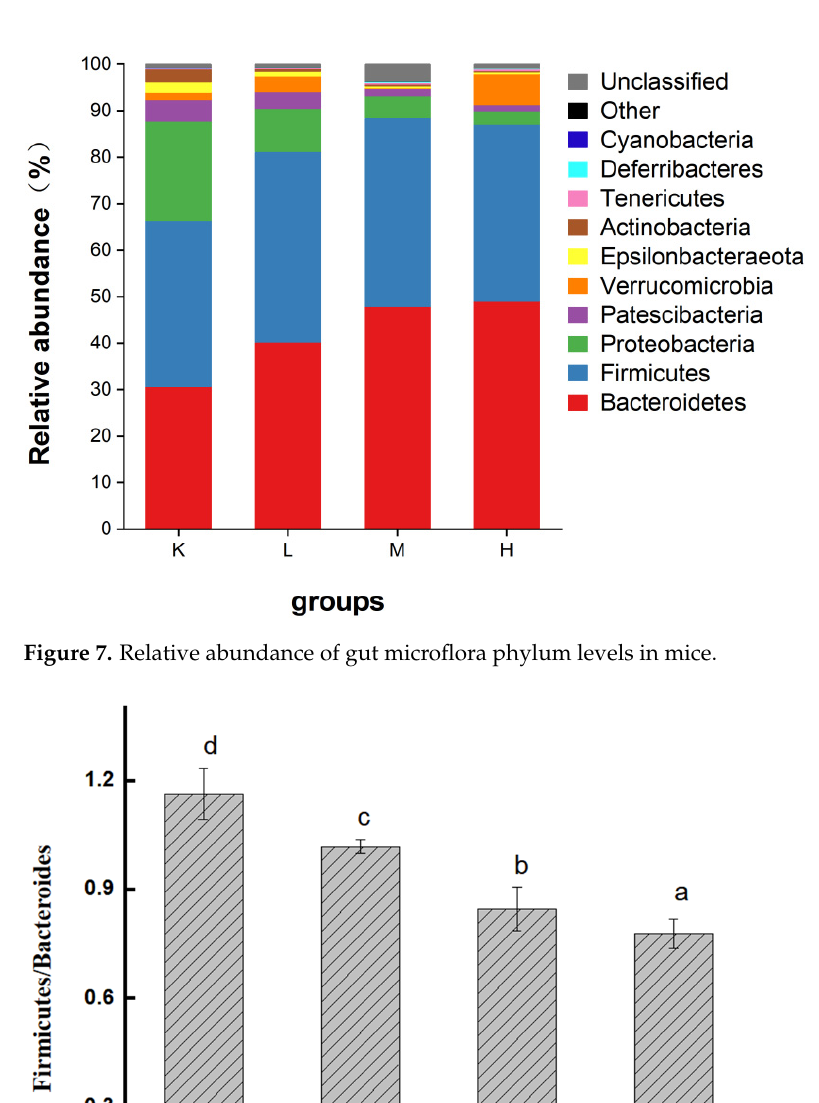
Figure 9. Heat map of species enrichment of gut microbiota in mice.